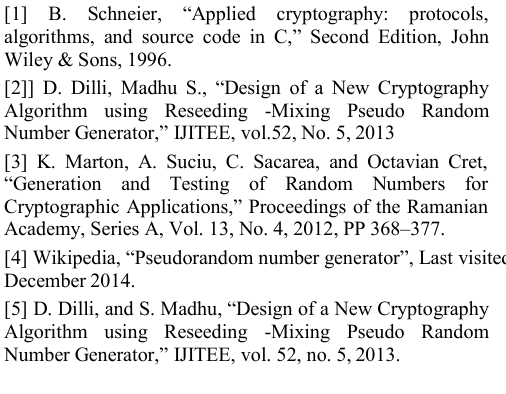
Table 2 Runs Test